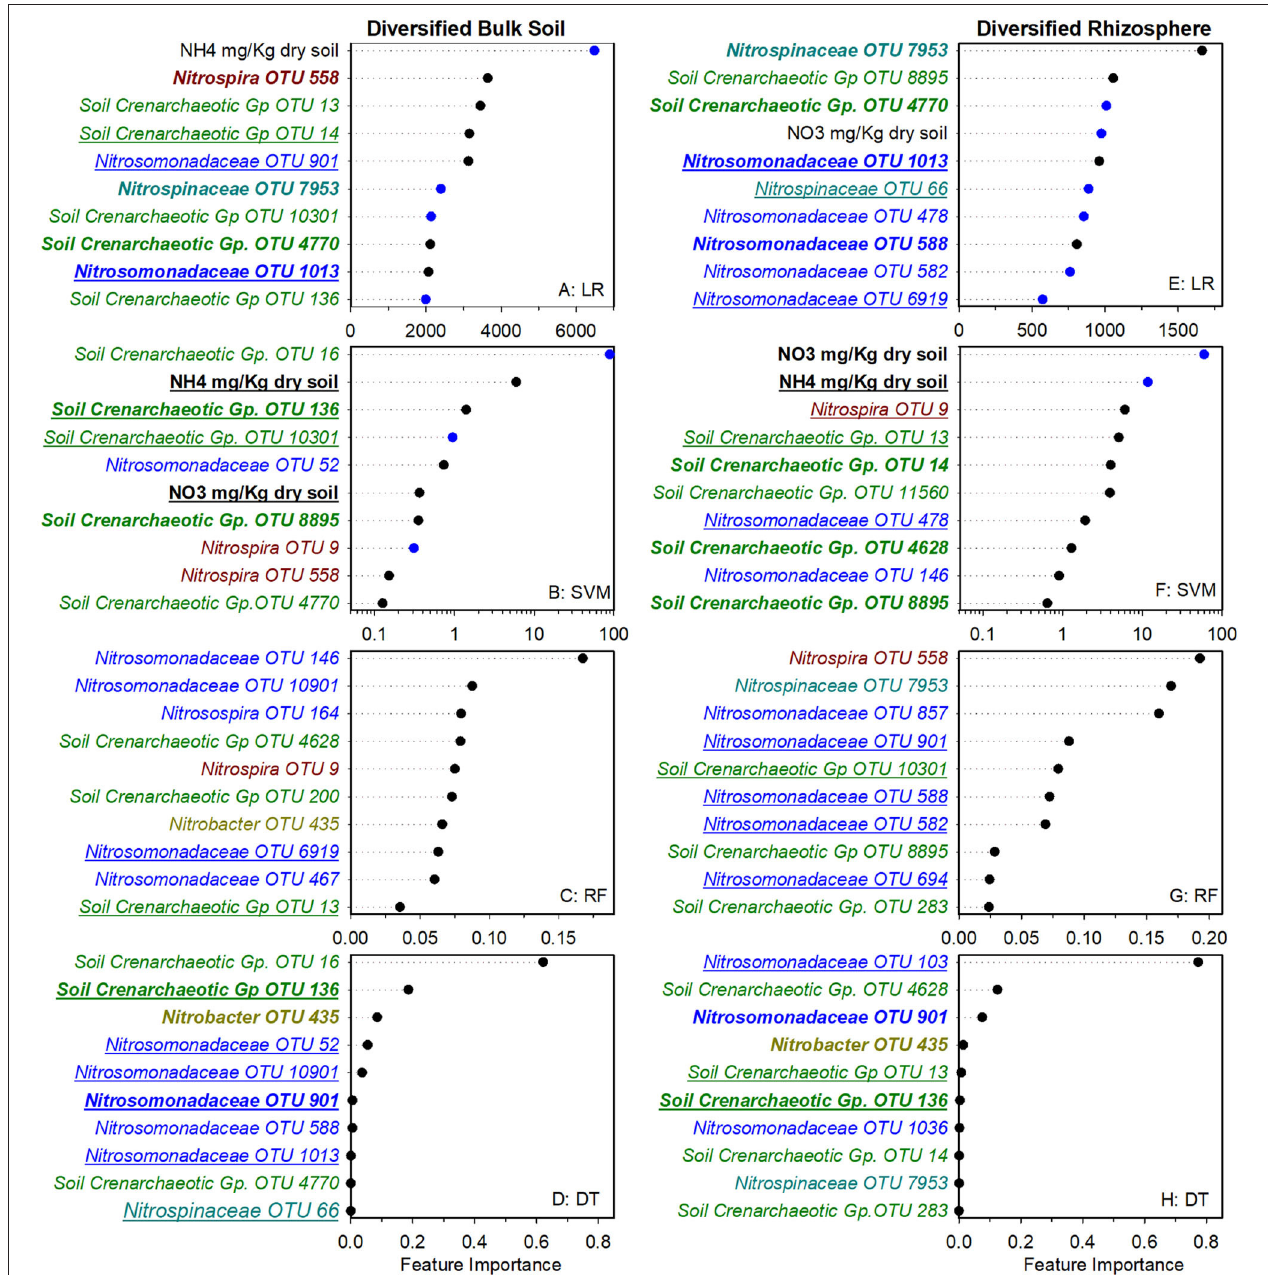
FIGURE 2 | Ranks of absolute feature weights of linear (A,B,E,F) and nonlinear (C,D,G,H) models for diversified bulk soil and rhizosphere. The 10 highest ranked features of absolute feature weights are displayed from highest to lowest. In regression (A,E) and SVM (B,F) , feature importance of OTUs positively associated with nitrification are represented by black dots, and those negatively associated with nitrification are shown in blue. Values for linear regression are the absolute feature importance, while for SVM, the log 10 relative absolute feature importance. Within each model, bold OTUs indicate the same OTUs in bulk soil and rhizosphere within a cropping system and underlined features indicate the same OTUs in bulk soil or rhizosphere between cropping systems. Random Forest (C,G) . Decision Tree (D,H)